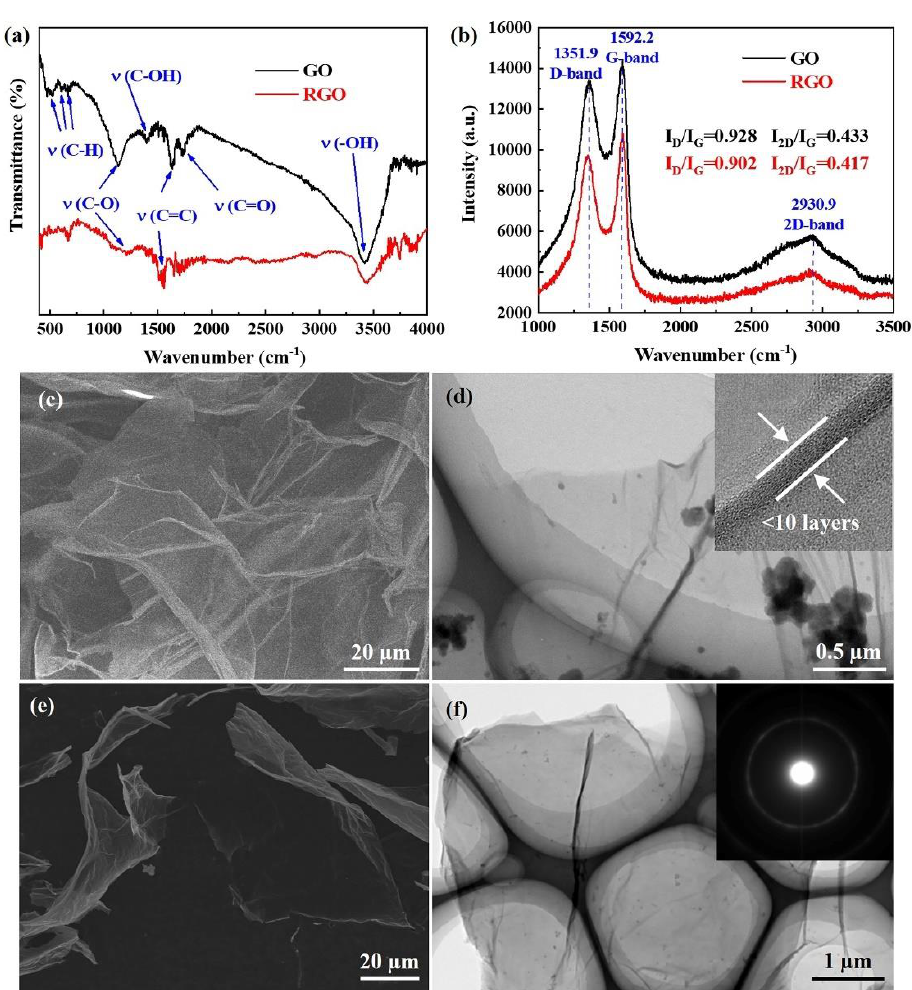
Figure 4. ( a ) FTIR spectrum and ( b ) Raman spectroscopy of GO and RGO. SEM and TEM micrographs of ( c , d ) GO and ( e , f ) RGO.